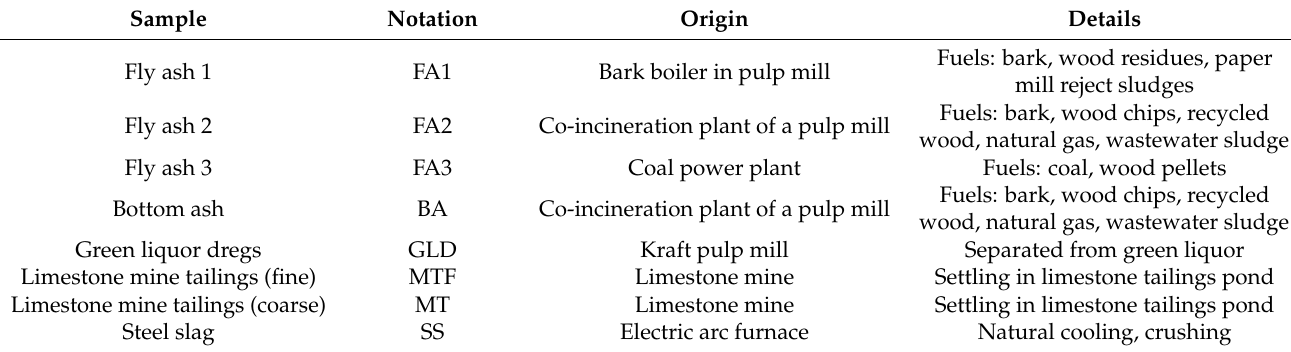
Table 1. Origins of the side